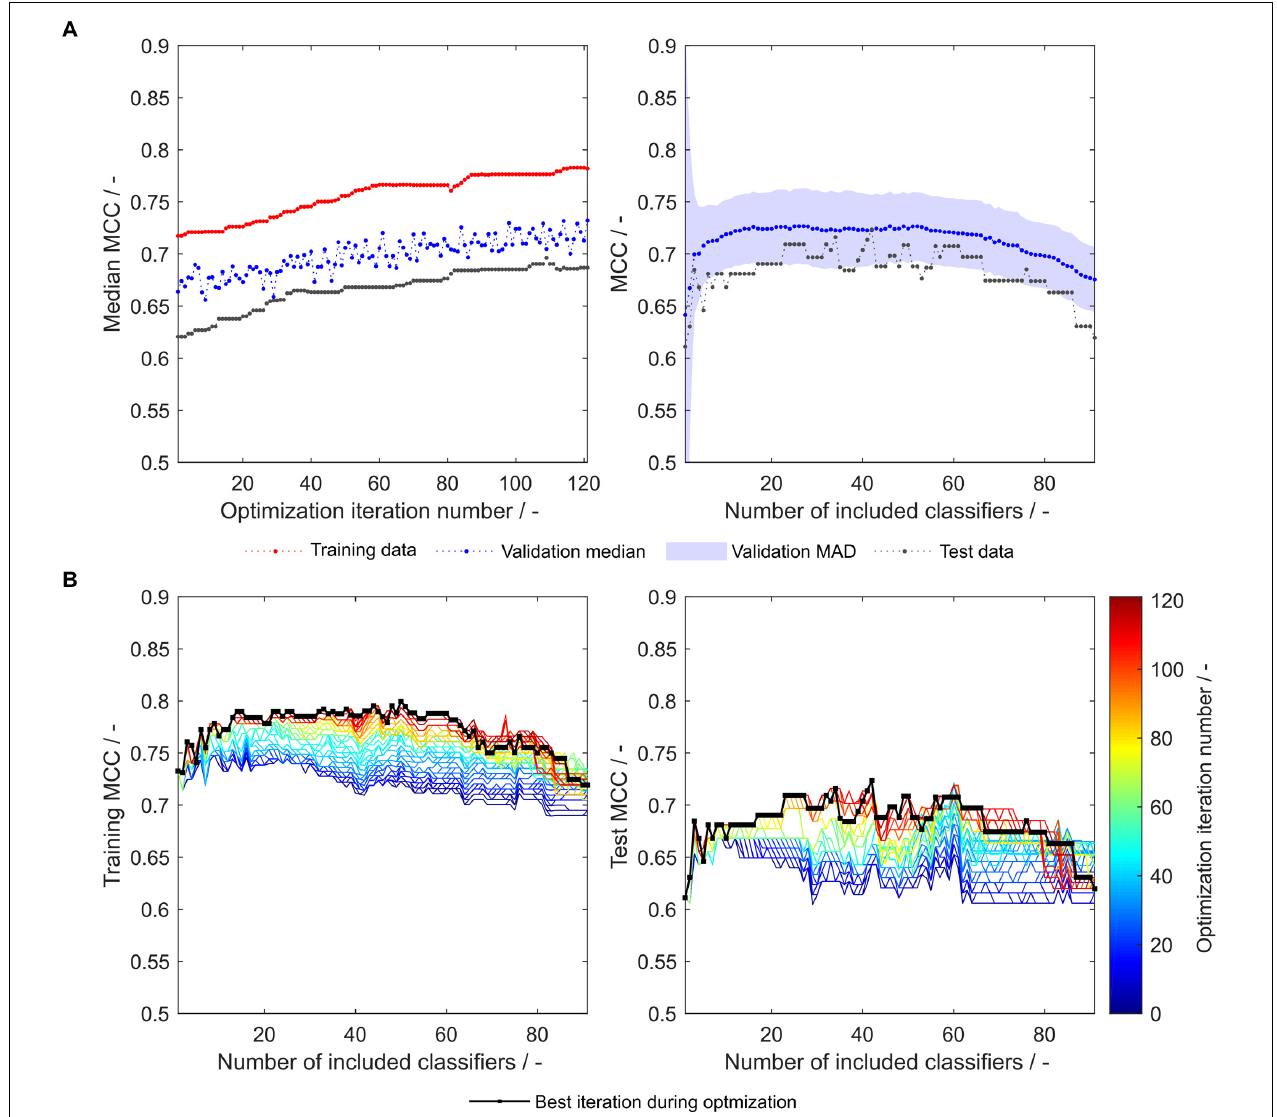
FIGURE 6 | Matthew’s correlation coefficient (MCC) during insertion strategy-based model optimization. Scales used were the optimized 91 literature scales (see also Figure 4 ). Median MCC are shown for training, validation, and test data over optimization iterations ( A , left). Validation and test MCC are shown over number of included classifiers in the soft ensemble vote classifier (sEVC; A , right) for the best model in the optimization procedure. The median absolute deviation (MAD) of the validation MCC above and below the median validation MCC is visualized by a shaded area. Training and test MCC over number of included classifiers are shown for the optimization iterations until the best iteration, where median validation MCC was highest (B) . Optimization iterations are illustrated by a colormap, where dark blue represents the first iteration and dark red the best iteration, highlighted by the black dots.